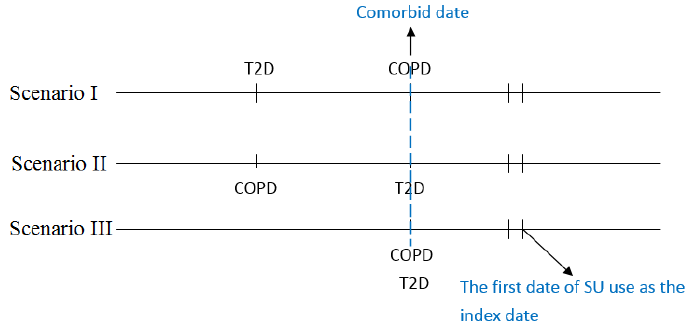
Figure 1. The scenarios for the diagnosis of T2D, COPD, comorbid COPD, and T2D, and the index